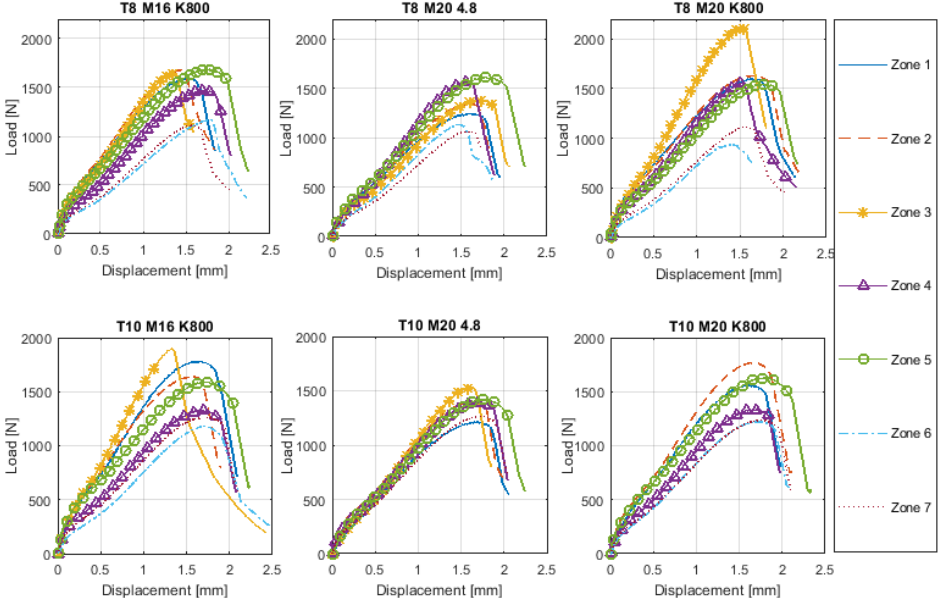
Figure 11. Load vs. displacement Small Punch Test (SPT) curves.